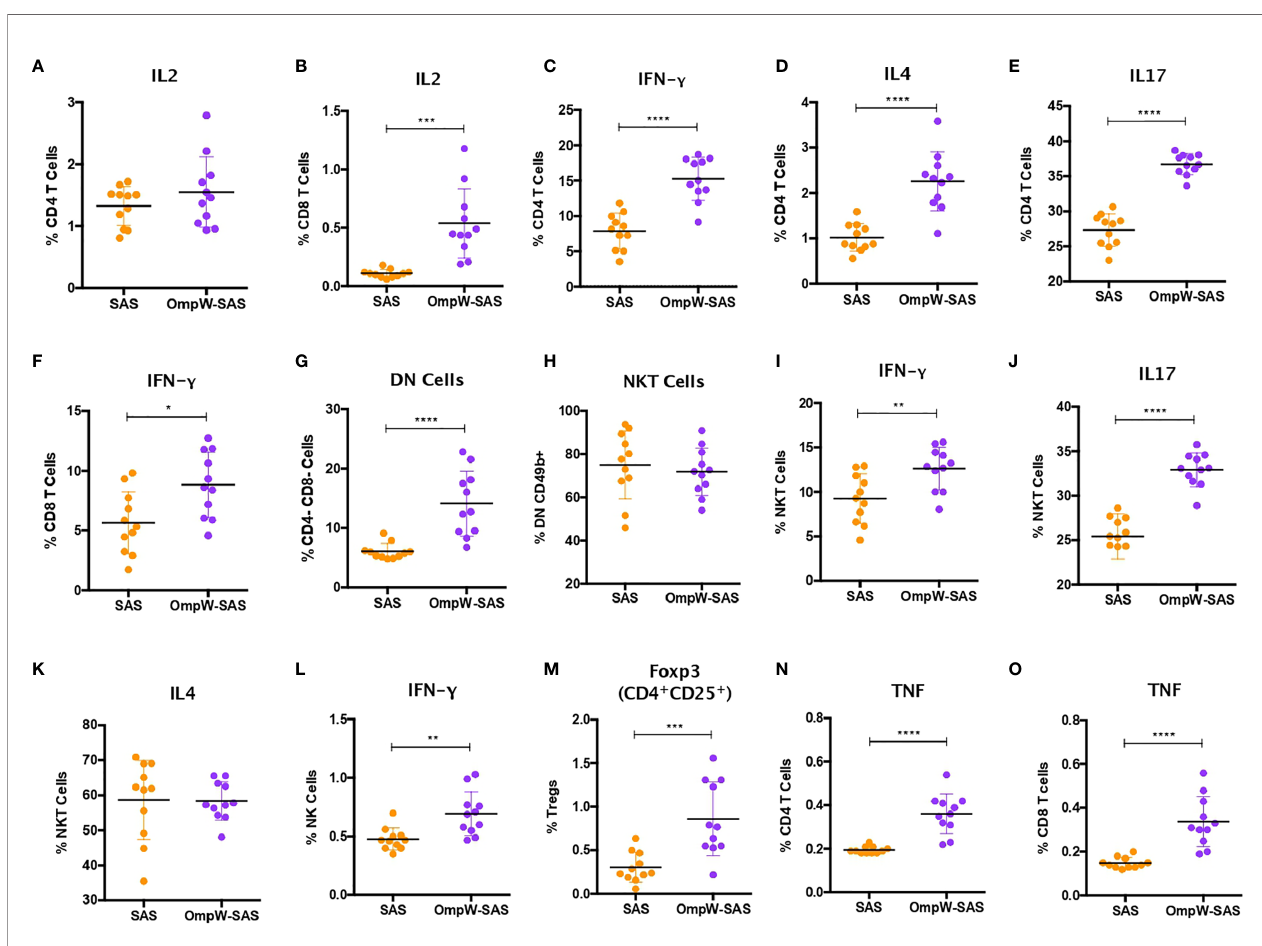
FIGURE 3 | BpOmpW immunization stimulated IFN- g responses in CD4 + , CD8 + , natural killer (NK), and natural killer T (NKT) cells and upregulated regulatory T cells (Tregs). (A, B) Percentages of CD4 (A) and CD8 (B) T cells expressing IL-2 cytokine. (C – E) Percentages of CD4 T cells expressing IFN- g (C) , IL-4 (D) , and IL-17 (E) . (F) Percentages of CD8 T cells expressing IFN- g . (G) Percentages of double-negative (DN) cells (CD4 − CD8 − ). (H) Percentages of NKT cells. (I – K) Percentages of NKT cells expressing IFN- g (I) , IL-17 (J) , and IL-4 (K) . (L) Percentages of NK cells expressing IFN- g . (M) Percentages of Tregs. (N, O) Percentages of CD4 (N) and CD8 (O) T cells expressing TNF. SAS , splenocytes from adjuvant-only mice exposed to BpOmpW ( orange circles , control) ( n = 11); OmpW-SAS , splenocytes from SAS-adjuvanted BpOmpW-immunized mice re-exposed to BpOmpW in vitro ( purple circles , treatment) ( n = 11). Asterisks denote statistically signi fi cant differences according to a two-tailed t -test. The levels of signi fi cance are represented as follows: * p < 0.05; ** p < 0.01; *** p < 0.001; **** p <